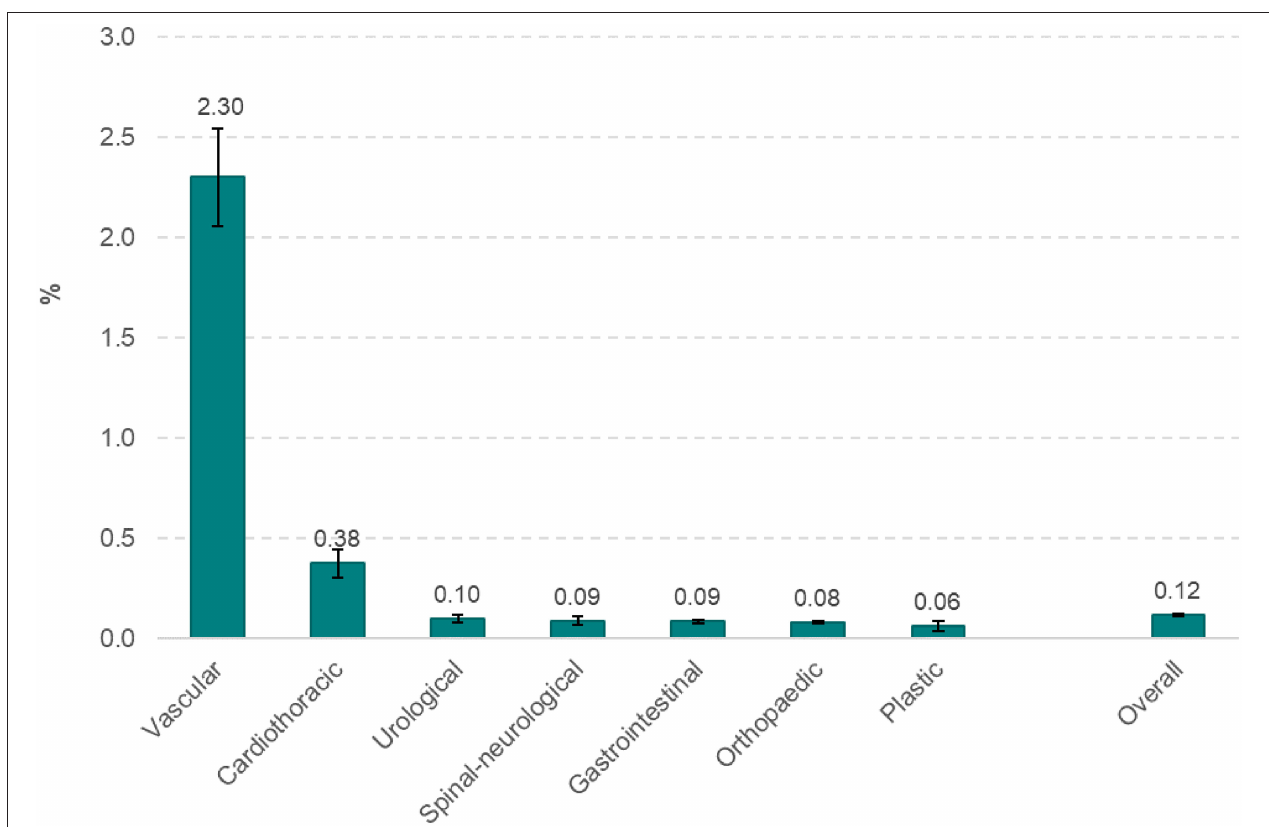
FIGURE 2 | Incidence of post-operative myocardial infarction by seven types of